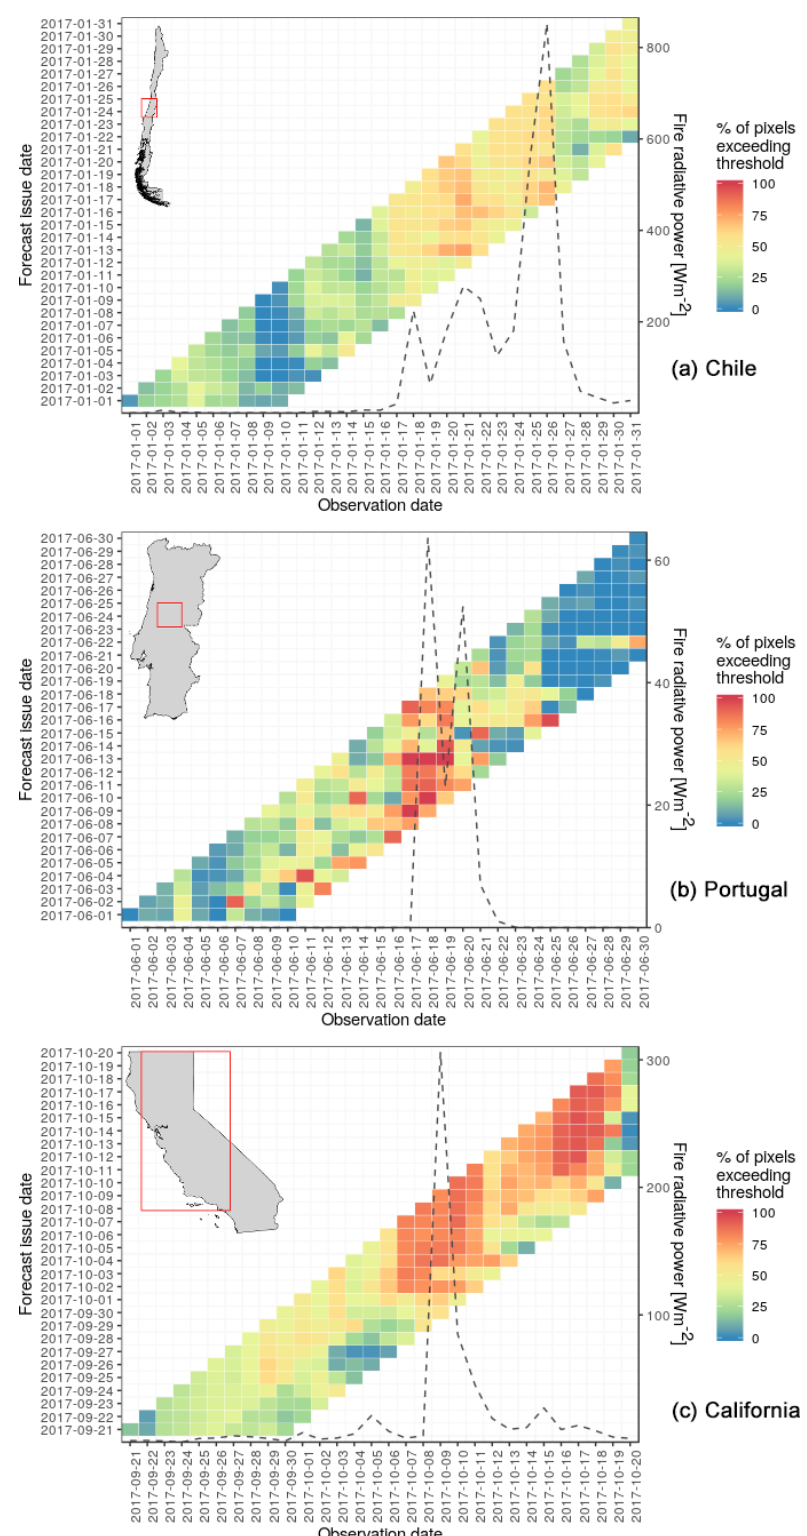
Figure 8. Comparison of FRP (dashed grey line with axis on the right-hand side) with the FWI forecasted using the deterministic high- resolution model for (a) Chile, (b) Portugal and (c) California. The FWI is colour-coded based on the percentage of pixels exceeding the high danger level calculated at the country and state level. Each of the panels refers to a specific fire event described in the text, and the statistics have been calculated over the red